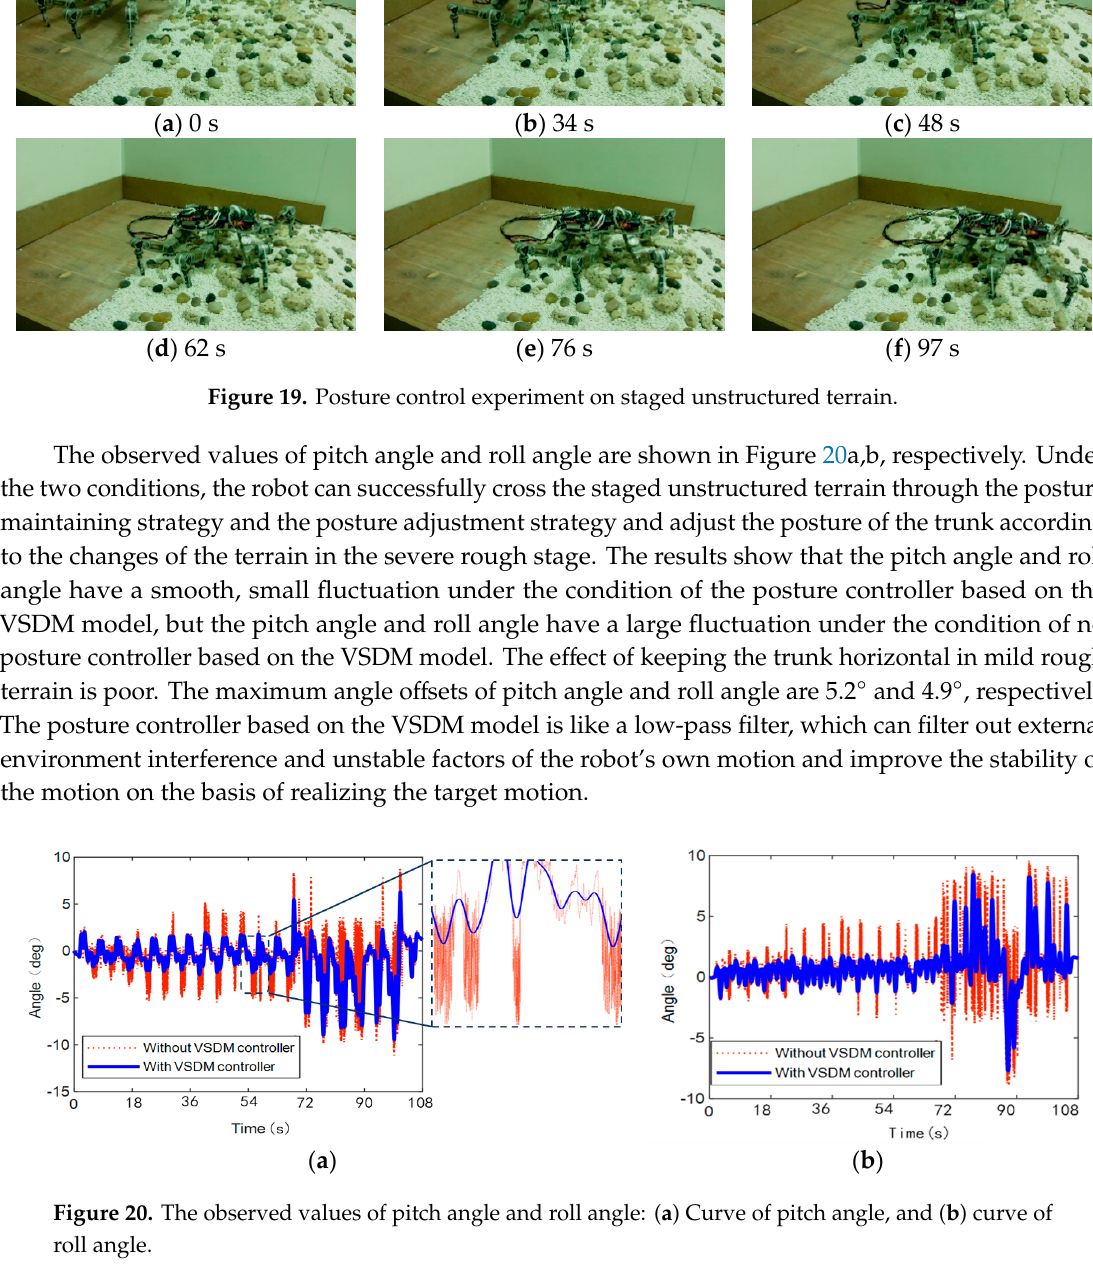
Figure 18. Staged unstructured terrain.